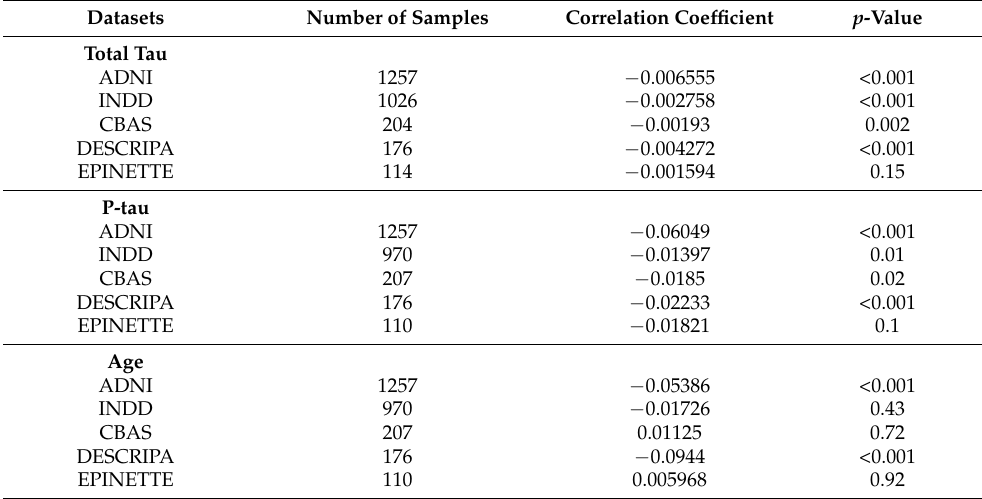
Table 4. The correlation between MMSE and CSF total tau level, p-tau level, or age for 5 datasets from the GAAIN database. p -Values < 0.05 indicated that the correlation coefficient is not equal to 0. Datasets Number of Samples Correlation Coefficient p